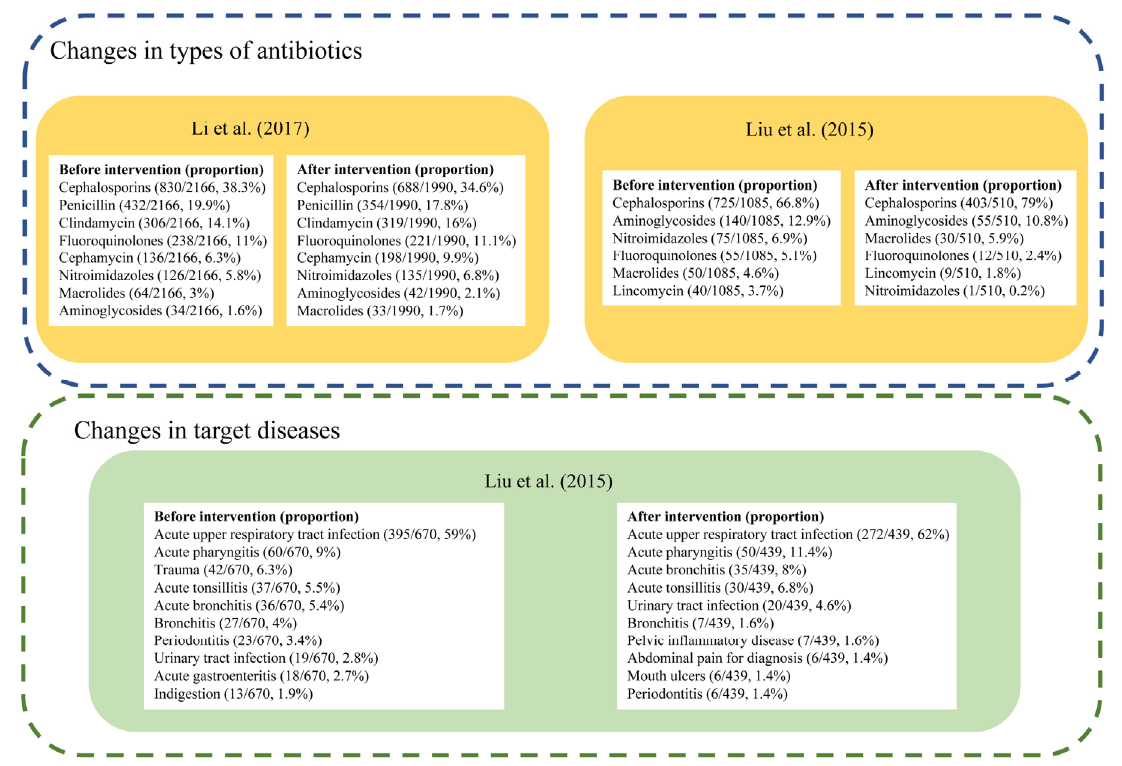
Figure 5. Changes of antibiotic prescription in types or target diseases [24,35].